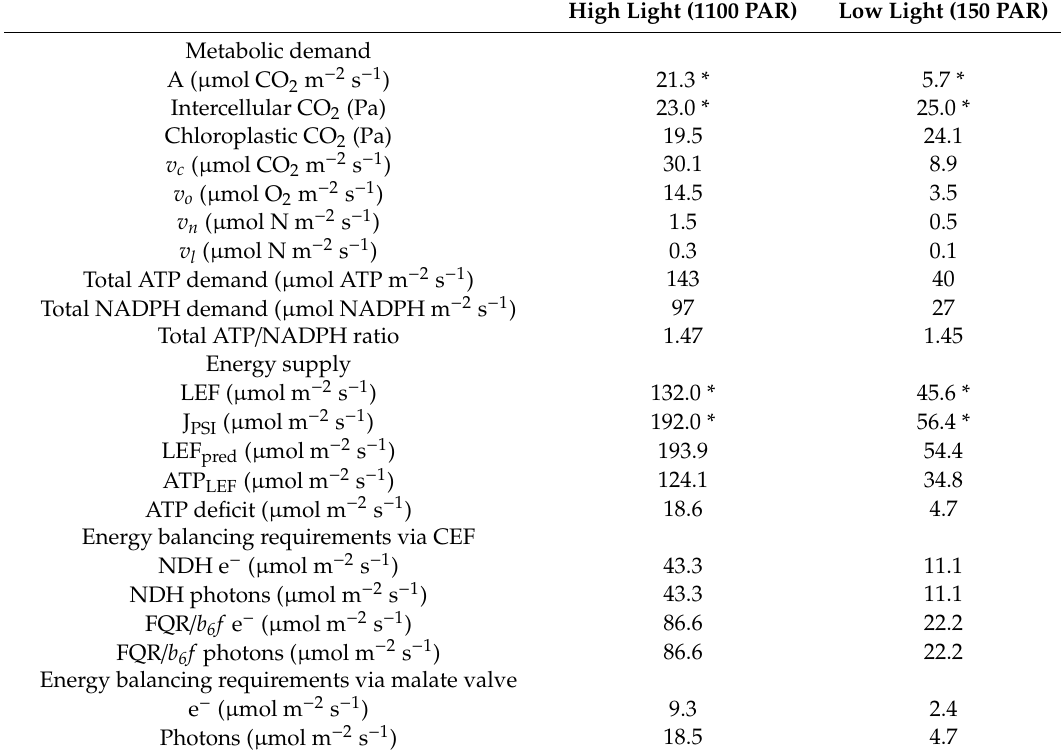
Table 1. Requirements for energy production for the supply and demand of the energy balancing network under low and high light in Nicotiana tabacum . For metabolic demand, shown are rates of CO 2 assimilation (A), intercellular and chloroplastic CO 2 concentration, rates of rubisco carboxylation ( v c ) and oxygenation ( v o ), rates of nitrate reduction ( V n ), rates of lipid production (V l ) and total ATP and NADPH demand. For energy supply shown are photosynthetically active radiation (PAR), measured rates of electron transport through PSII (LEF) and PSI (J PSI ), rates of linear electron flux needed to provide su ffi cient NADPH for metabolic demand (LEF pred ), ATP produced from LEF pred (ATP LEF ) and the ATP deficit. For energy balancing, shown are the electron and photon demands for the ATP deficit to be provided by CEF via the NDH, FQR or b6f pathways or the malate valve. Details for these calculations found in the text. Values taken from Miyake et al. 2005 [1] indicated with a star (*), with remaining values calculated or assumed herein. For these calculations R l , Γ * and g m were assumed